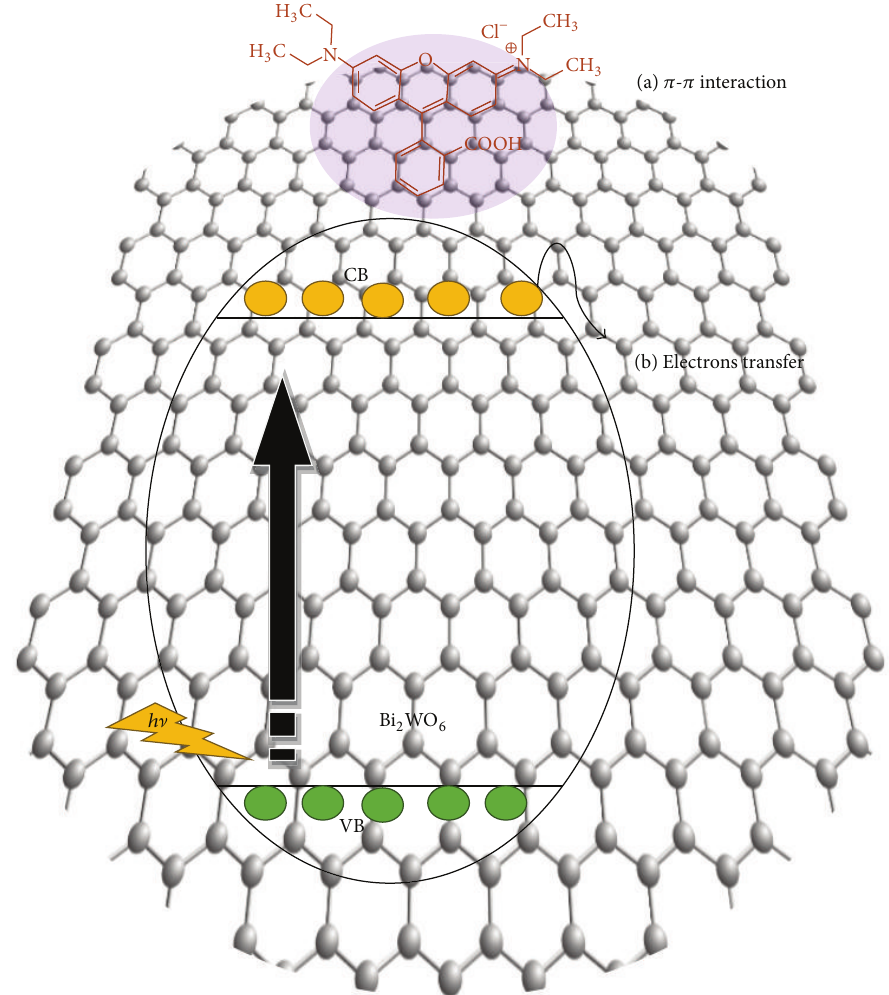
Figure 9: The proposed mechanism of RhB adsorption on graphene by (a) 𝜋 - 𝜋 interaction and possible electrons transfer after activation by photon